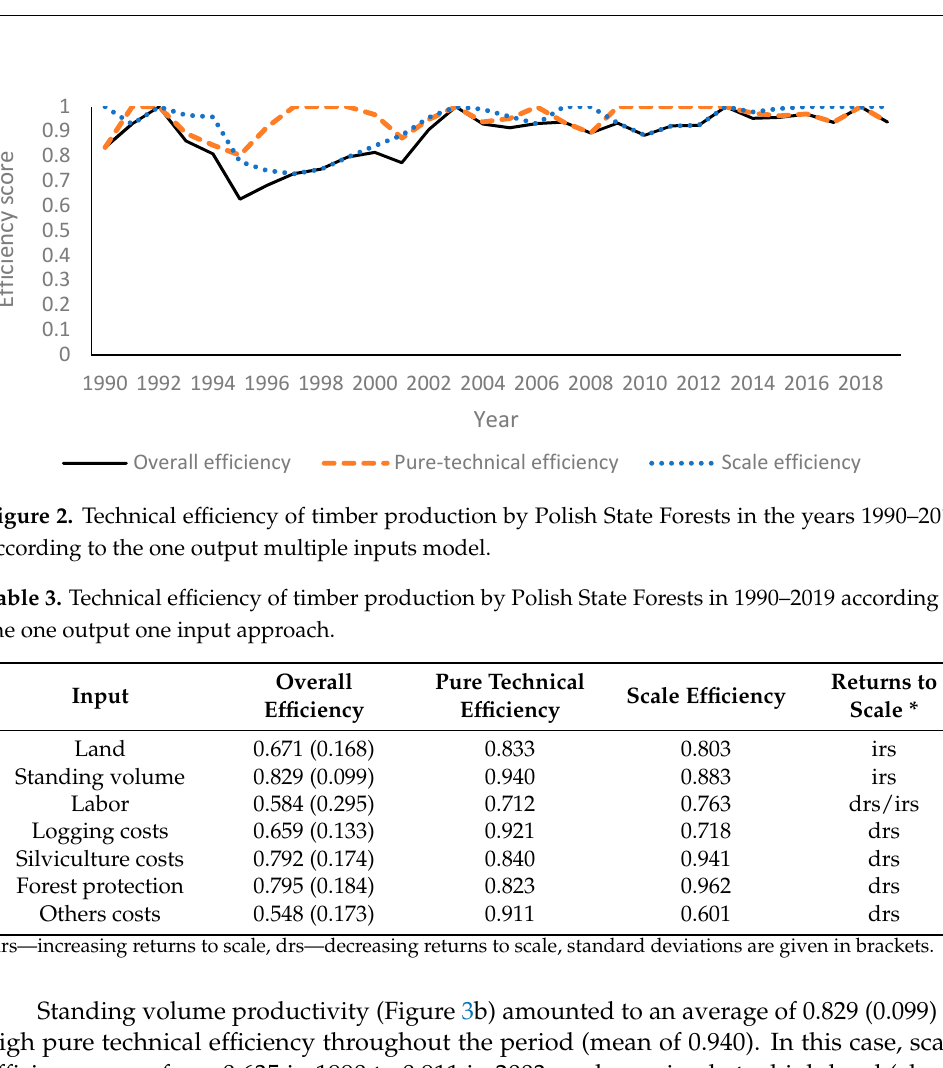
Table 3. Technical efficiency of timber production by Polish State Forests in 1990–2019 according to the one output one input approach.